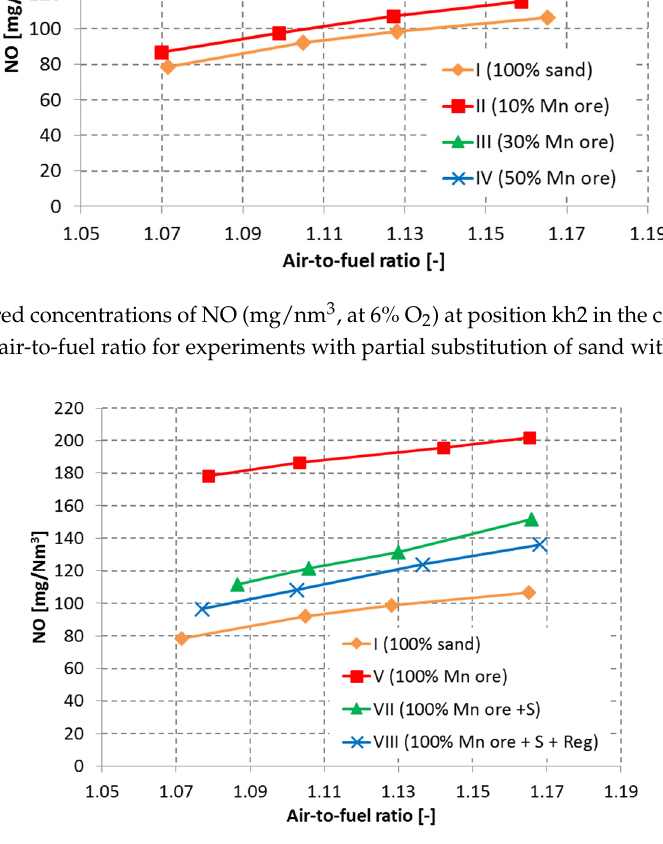
Figure 8. Measured concentrations of NO (mg/nm 3 , at 6% O 2 ) at position kh2 in the convection path as a function of the air ‐ to ‐ fuel ratio for experiments with 100% manganese ore.